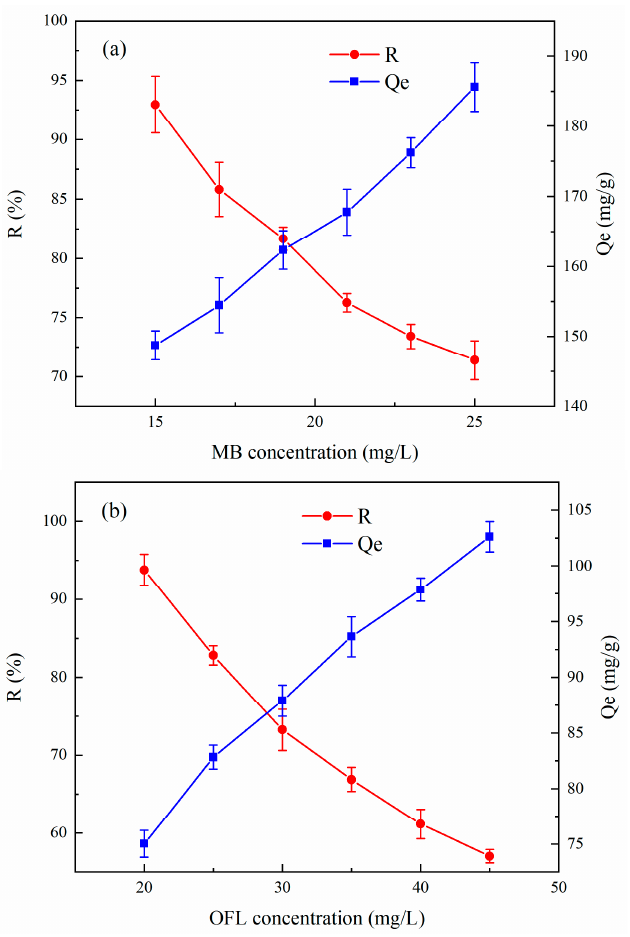
Figure 8. Removal efficiency of ( a ) MB and ( b ) OFL adsorbed by SAC versus adsorption amount with initial concentration.